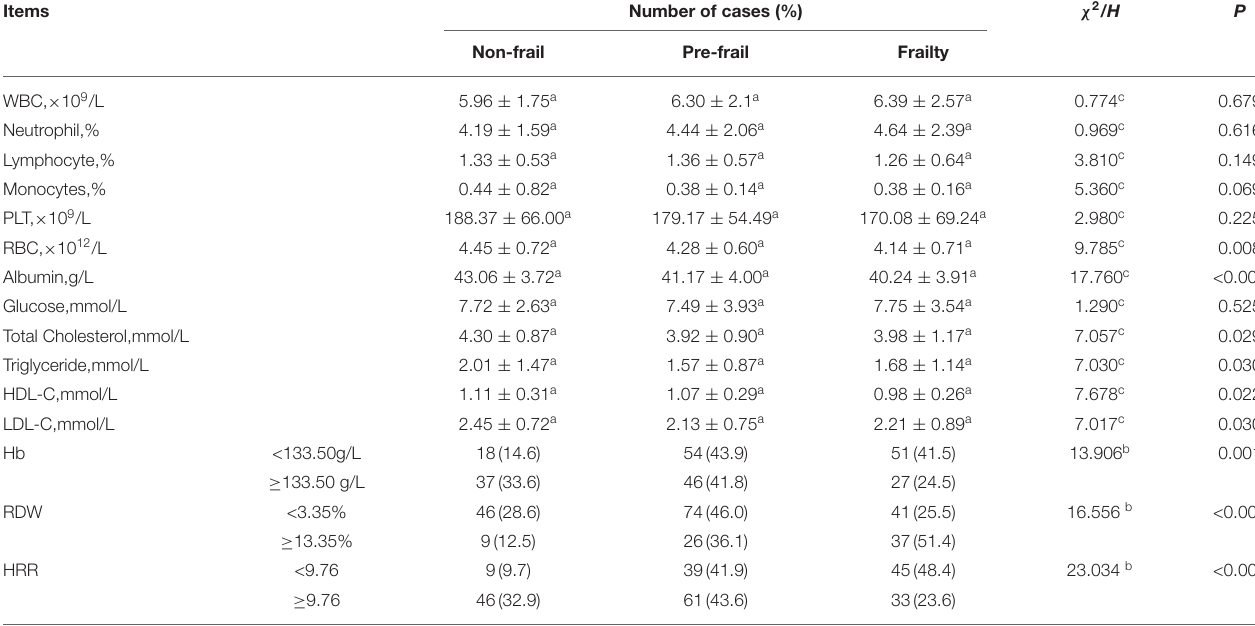
TABLE 3 | Univariate analysis of blood parameters and frailty in elderly patients with CHD. Items